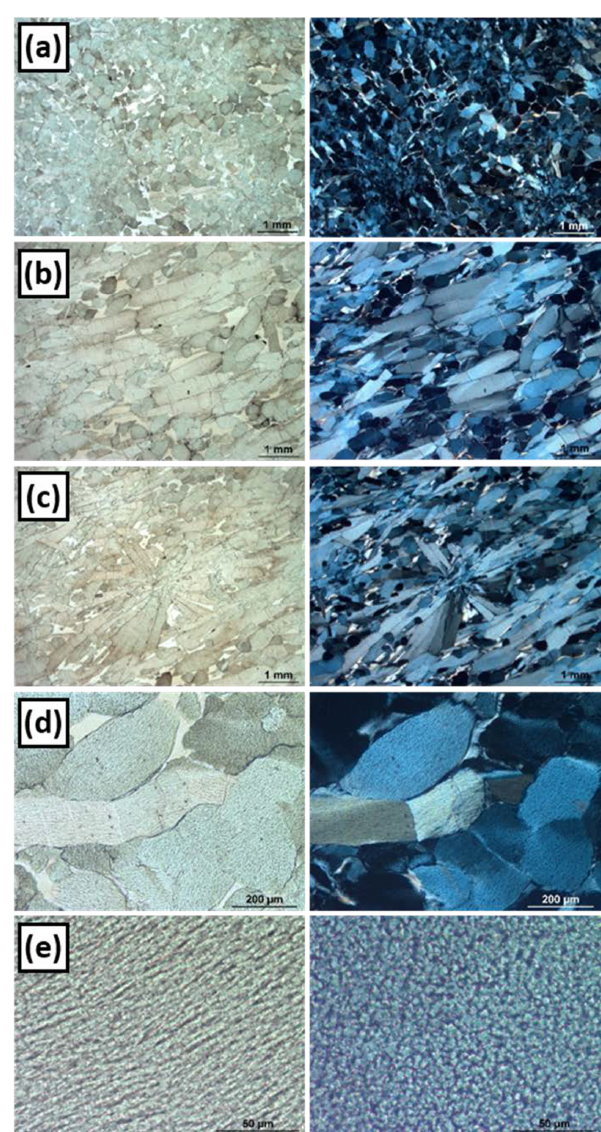
Figure 1. Photomicrographs of the lizardite vein. (a) Perpendicu- lar to mineral lineation. The colourless interstitial matrix (left) con- sists of chrysotile and polygonal serpentine. Left: plane-polarized light (PPL). Right: crossed polarizers (XPs). Thin section MM91A. (b) Parallel to mineral lineation. Left: PPL; right: XPs. Thin sec- tion MM91B. (c) Radial aggregate of prismatic lizardite, grown in a vein with main foliation (ENE-WSW) still evident. Left: PPL; right: XPs. Thin section MM91B. (d) Lizardite prism with evident post- crystalline deformation features. Left: PPL; right: XPs. Thin sec- tion MM91B. (e) High-magnification photomicrographs of lizardite crystals, cut parallel (left) and perpendicular (right) to prism elon- gation. PPL, thin section